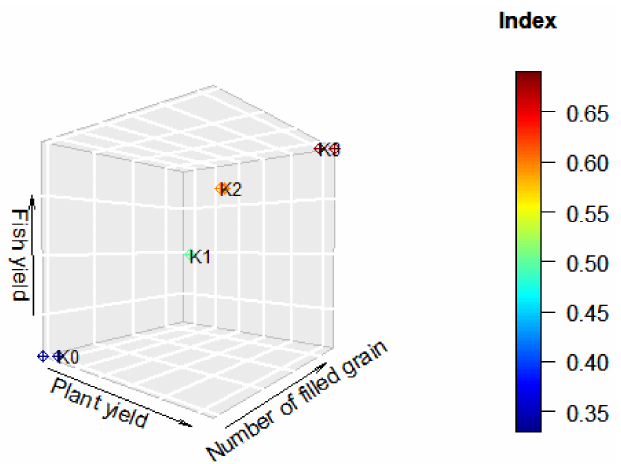
Figure 5. Regression analysis of the dose of compost on the increase in the yield of fish. The results of the 3D plot analysis focused on the three main characters, namely, the number of filled grains, rice yield, and fish yield (Figure 6). The combination of the three characters was focused on the compost treatment. Based on this analysis, adding compost (K1, K2, and K3) had a better combination index value than adding compost (K0). The four ton ha − 1 (K3) treatment was the treatment with the best index value and is found at the top end of the 3D plot. Meanwhile, the R/C ratio analysis is shown in Table 7. Based on this table, the best application of the compost was at a compost dosage of four tons ha − 1 . In contrast, the lowest R/C ratio was found in the control treatment (0 tons ha − 1 ).